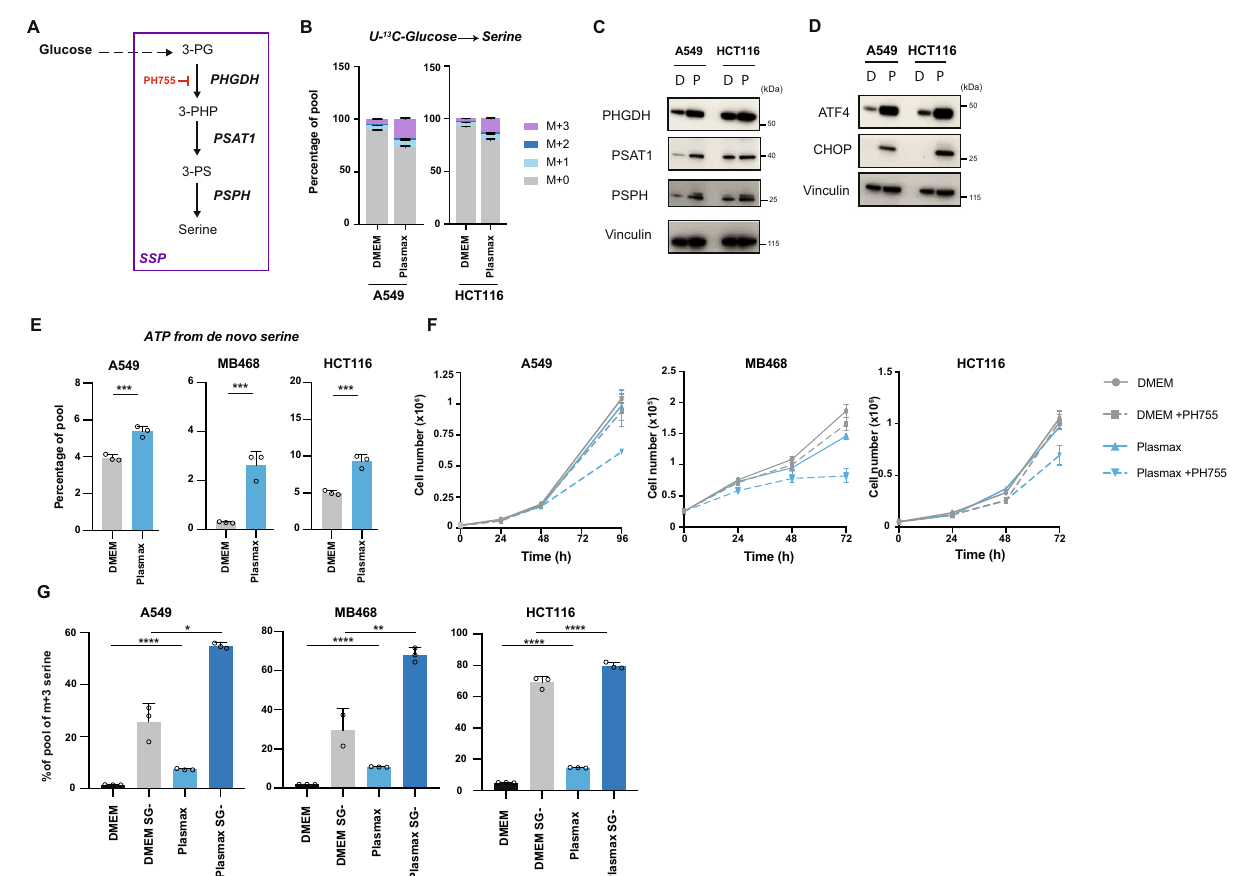
Fig. 2 Upregulation of the de novo serine synthesis pathway in Plasmax. A Serine can be synthesised de novo from 3-phosphoglycerate (3-PG) derived from glucose by a 3-step enzymatic reaction. The fi rst is an NAD + -dependent reaction catalysed by PHGDH which converts 3-PG into 3-phosphohydroxypyruvate (3-PHP). 3-PHP is then converted by PSAT1 into 3-phosphoserine (3-PS) which is subsequently hydrolysed into serine by PSPH. B Percentage of pool of intracellular serine measured by LC – MS after incubation for 4 h with 22.5 mM or 5.5 mM of U- 13 C-glucose in DMEM or Plasmax, respectively. Data are represented as mean ± SD of triplicate wells. C Western blot of SSP enzymes of cells grown in DMEM (D) or Plasmax (P) for 72 h. Membrane was reprobed with Vinculin as a loading control. Blots are representative of 2 independent experiments. D Western blot of ATF-4 pathway of cells grown in DMEM (D) or Plasmax (P) for 72 h. Membrane was reprobed with Vinculin as a loading control. Blots are representative of 3 independent experiments. E Sum of ATP M + 6, ATP M + 7, ATP M + 8, ATP M + 9 percentage of pools measured by LC – MS after incubation for 4 h with 22.5 mM or 5.5 mM of U- 13 C-glucose in DMEM (grey) or Plasmax (blue). Data are represented as mean ± SD of triplicate wells (unpaired Student ’ s t test, *** p < 0.001). F Growth curve of cells grown in DMEM (grey) or Plasmax (blue) with or without 10 µ M of PH755. Data are represented as mean ± SD of triplicate wells. G Percentage of M + 3 serine pools after incubation for 4 h with U- 13 C-glucose in DMEM (black), DMEM SG- (grey), Plasmax (light blue) or Plasmax SG- (dark blue) with or without serine/glycine (SG-). Data are represented as mean ± SD of triplicate wells (multiple comparison by one-way Anova, * p < 0.05, ** p < 0.01, *** p < 0.001, **** p < 0.0001). All graphs are a representative of 3 independent experiments. Source data are provided as a Source Data fi